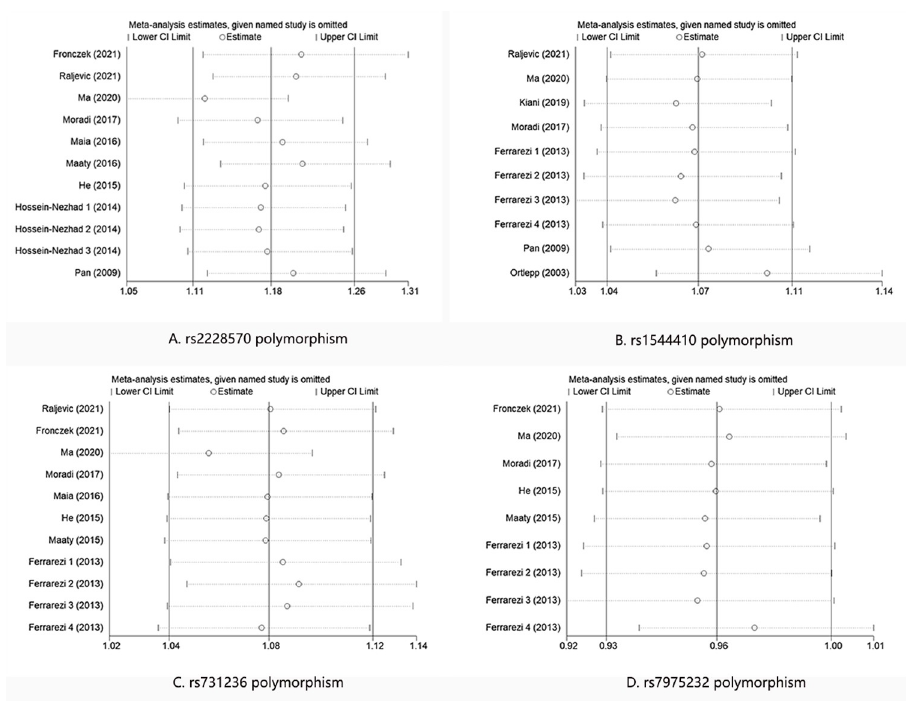
Fig 3. Sensitivity analysis of CAD risk associated with the VDR polymorphism. A: rs2228570 polymorphism; B: rs1544410 polymorphism; C: rs731236 polymorphism; D: rs7975232 polymorphism. CAD = Coronary artery disease, VDR = vitamin D receptor, OR = odd ration, CI = confidence